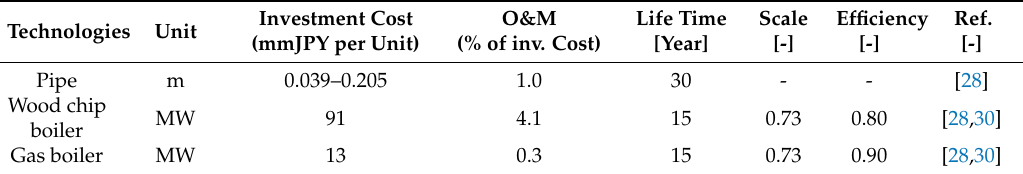
Table 1. Parameters for district heating system